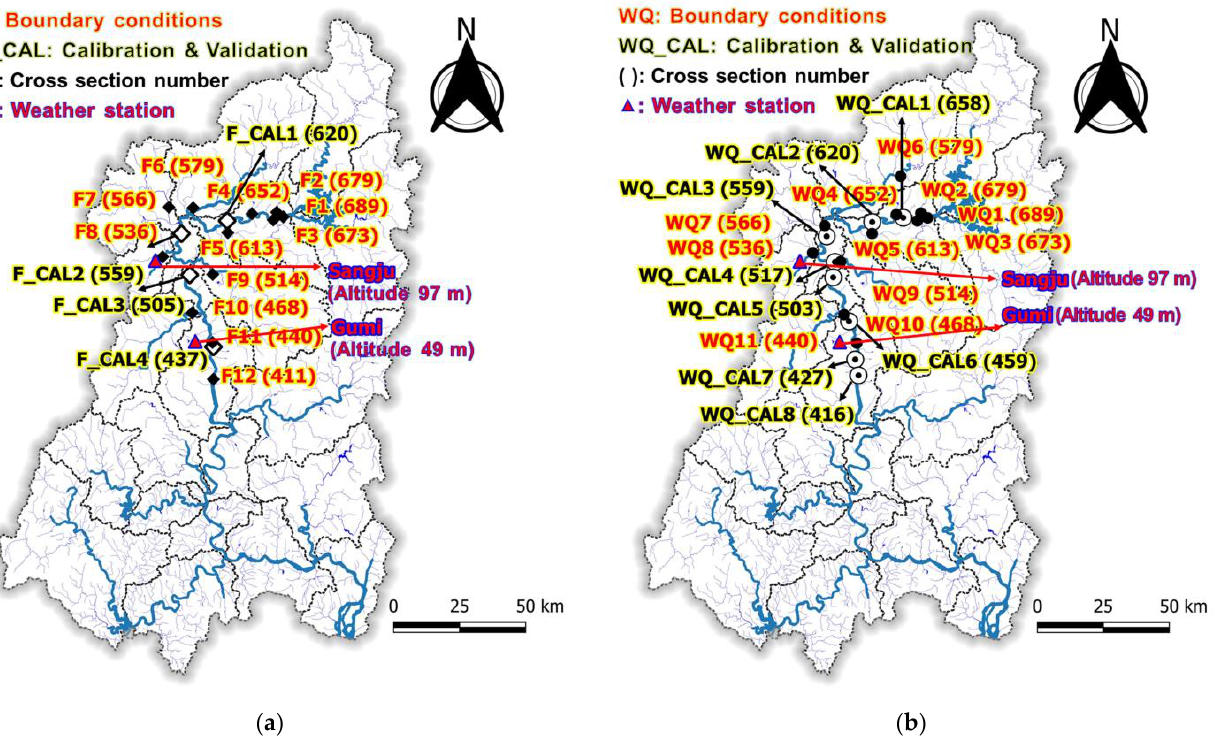
Figure 2. Location of the monitoring stations. ( a ) Stations for hydraulic data and two weather stations; ( b ) stations for water quality data and two weather stations.